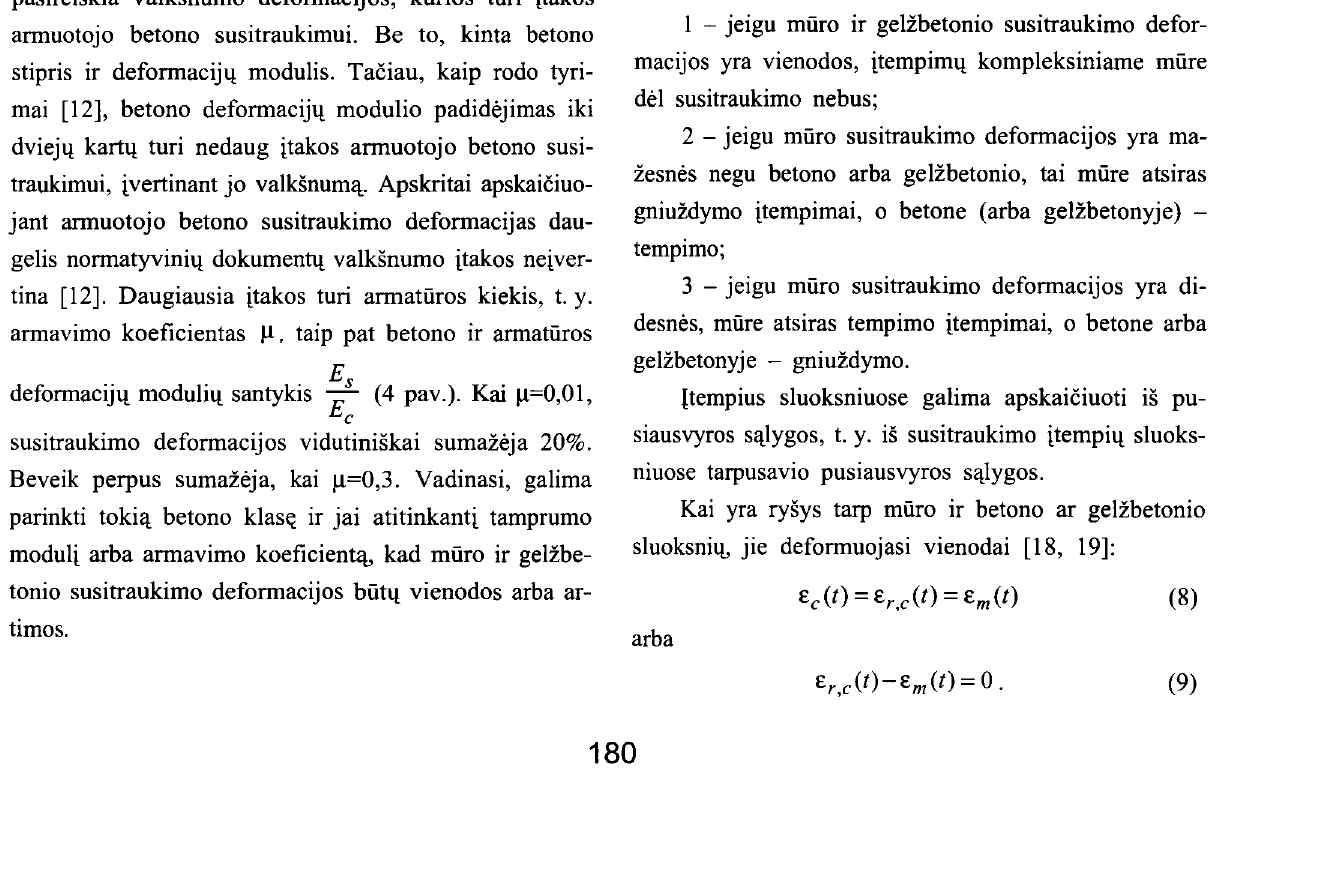
4 pav. Armavimo !l koeficiento ir deformacijl.l modulil.l 2- 8; 3 - 6 Fig 4. Reinforced ratio ( !l) and modulus ratio E s / E c influence on shrinkage of concrete: I - E s / E c = 10; 2- 8; 3 - 6 3. Jtempimq ir deformacijq biiviai del skirtingo